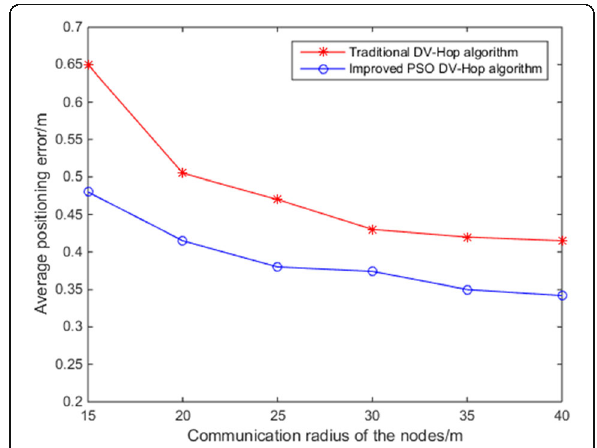
Fig. 6 Average location errors with different beacon node densities Fig. 7 Average location errors with different communication